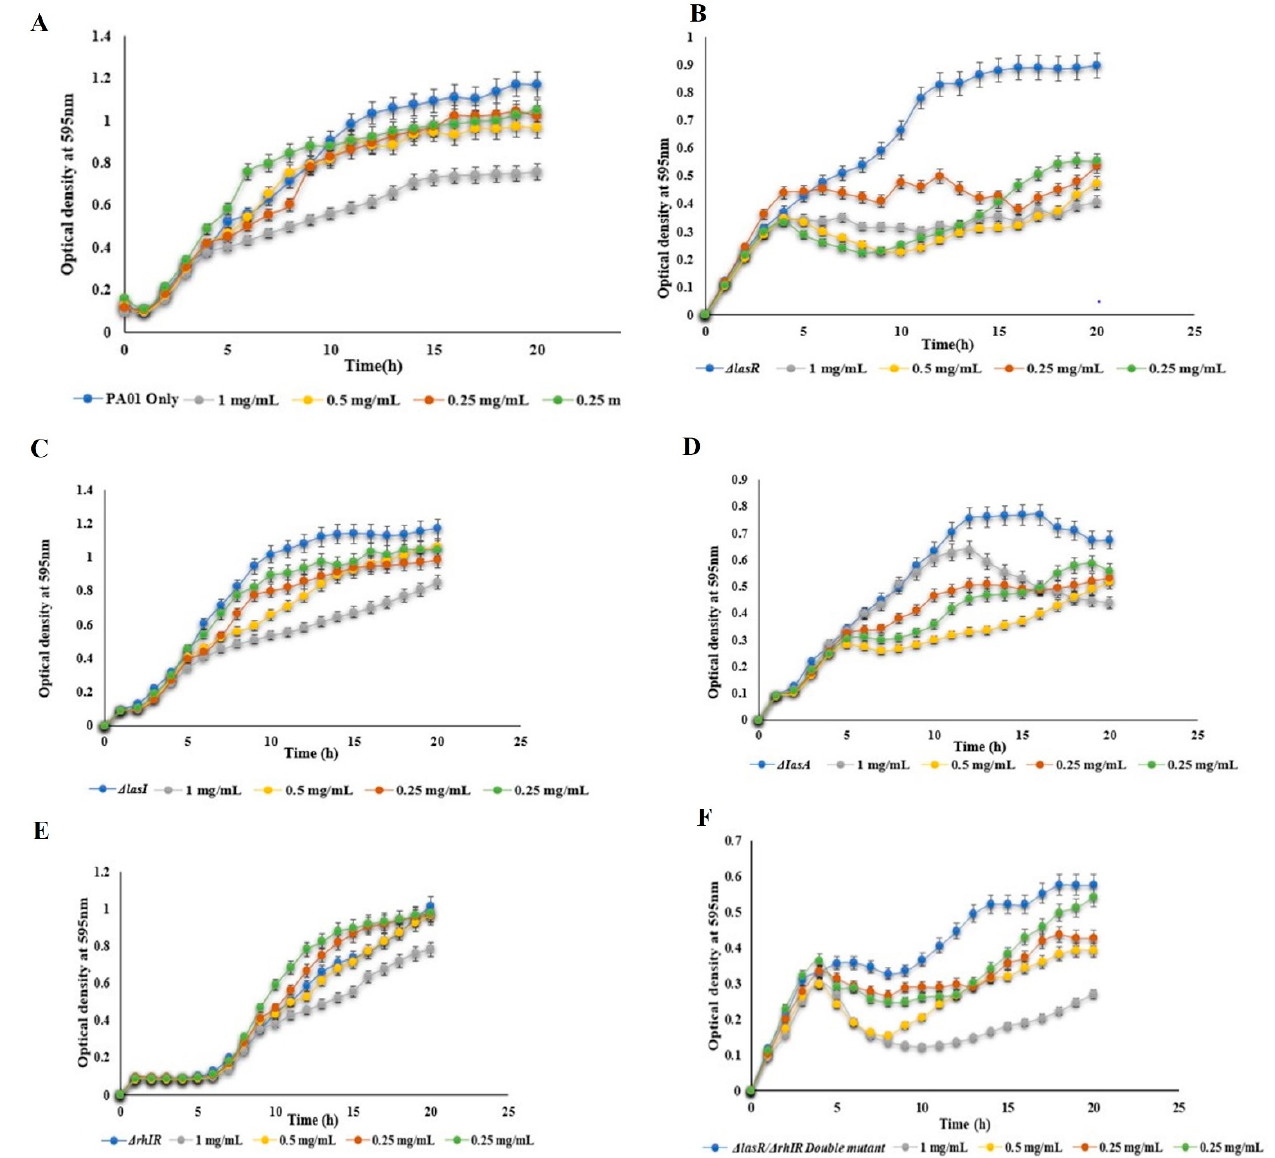
Figure 1. The effect of free mBTL at different concentrations was investigated using ( A ) wild type PA01 and different pseudomonal QS mutants ( B ) PA1430 ( ∆ LasR ), ( C ) PA1432 ( ∆ lasI ), ( D ) PA1871 ( ∆ IasA ), ( E ) PA3477 ( ∆ rhlR ), and ( F ) PA1871 ( ∆ lasR/ ∆ rhlR ) double mutants. All experiment performed three times in triplicate.